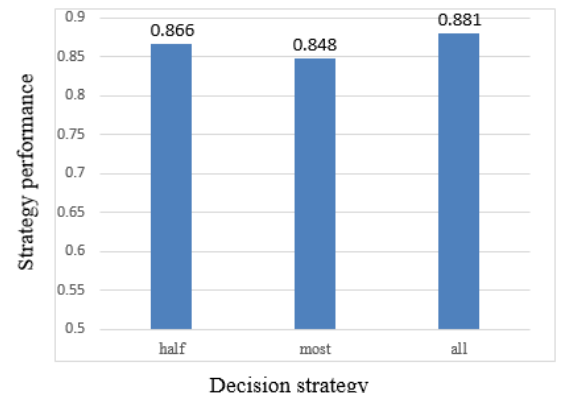
Figure 8 - Percent of performance of “Q-OWA and Fuzzy